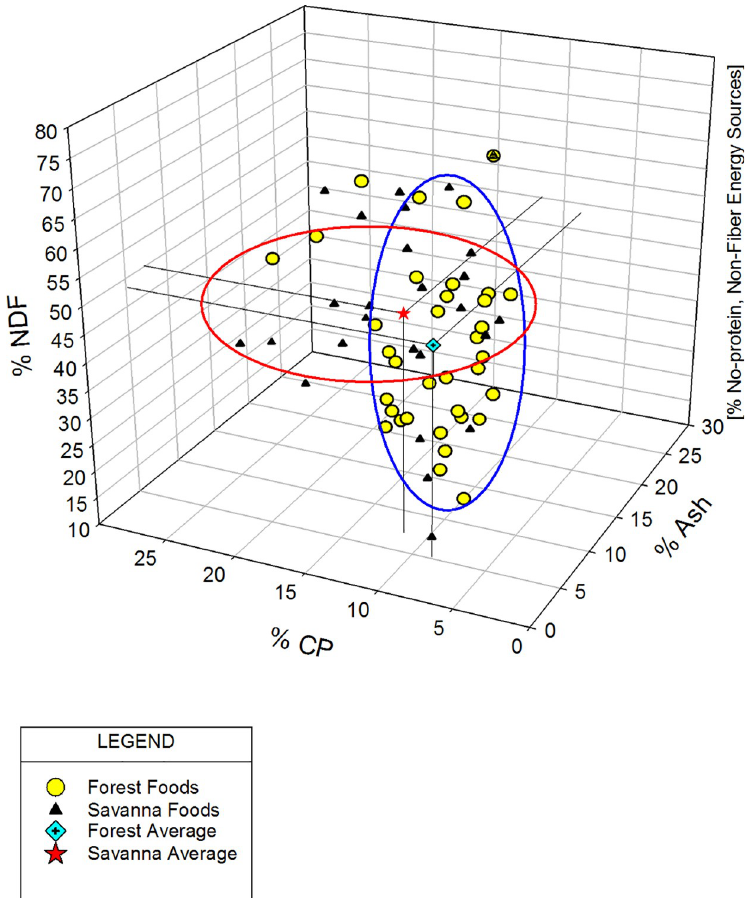
Fig 1. Mchelelo baboon forest vs. savanna foods macronutrient content–right-angled mixture triangle, all foods with cluster ellipses.